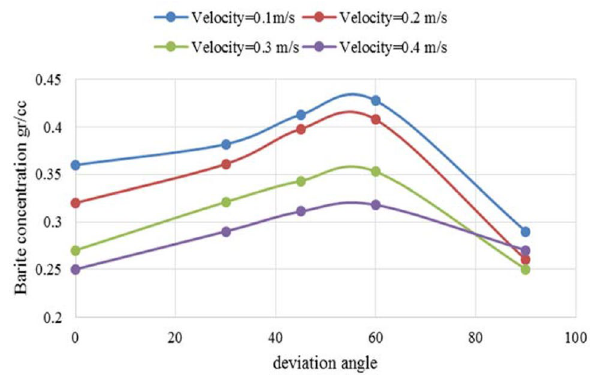
Fig. 7 Change in the amount of particles deposited in the circular space as a function of flow rate and deviation